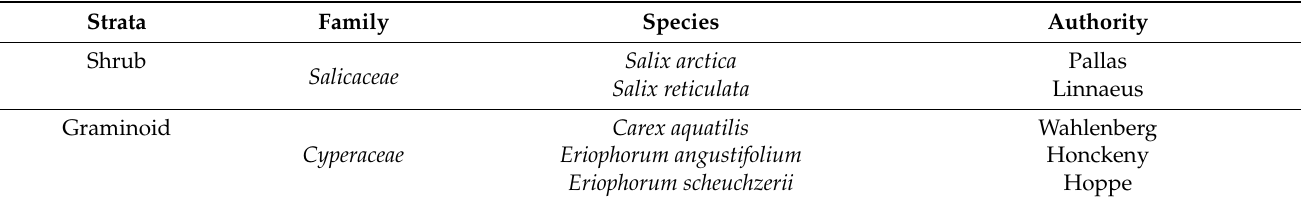
Table A1. List of plant species encountered during the summer 2019 inventories in the tundra wetlands of the Qarlikturvik Glacial Valley on Bylot Island (Nunavut, Canada). Nomenclature follows VASCAN [112] for vascular plants and BRYOQUEL [113] for